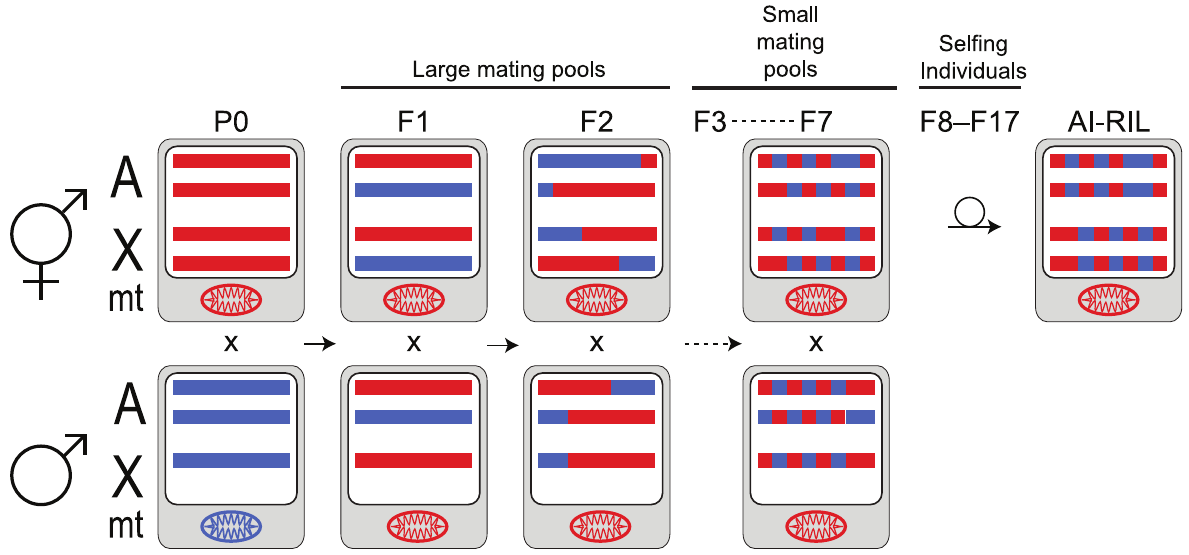
Figure 1. AI-RIL cross scheme. An autosome pair (A) and the X chromosome pair (X) are depicted as horizontal bars for each parent in selected generations. Males have a single maternally-inherited X chromosome. Chromosomes are shown on a white background, representing the nucleus. The oval mitochondrial genome (mt) is shown on a gray background, representing the cytoplasm. P0 strains AF16 (red) and HK104 (blue) were crossed in both directions (AF16 male 6 HK104 hermaphrodite shown here). The F1 hybrids are mated with siblings; sib-mating continues through the F7. F8 hermaphrodites were selfed to produce an F9 generation; continual selfing through F17 was employed to inbreed the lines. Color-coded blocks depict the increase of haplotype breakpoints and homozygosity with generation. Under neutral expectations, two thirds of the X